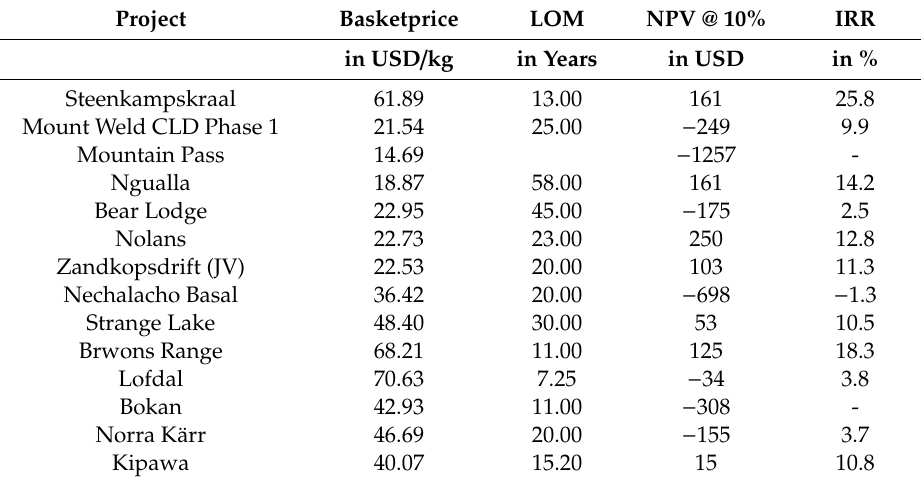
Figure 3. Results of the DCF model with a 10% discount rate (pre-tax) and base case prices. Table 3. Detailed results of DCF model for base case